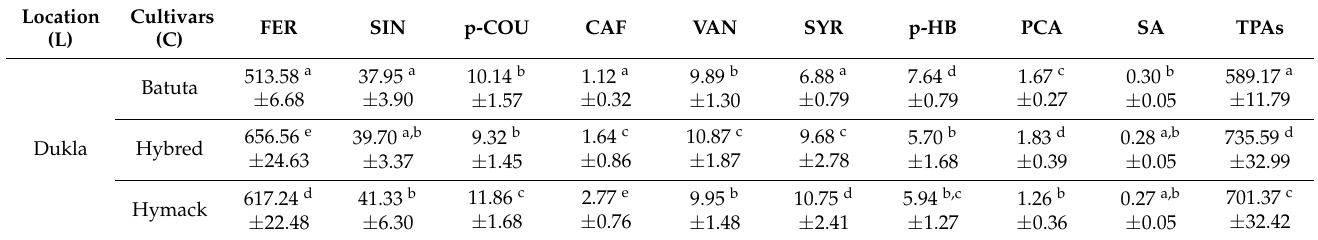
Table 5. Phenolic acid (PA) composition of wheat grain [ µ g g − 1 ], mean values for interaction location ×